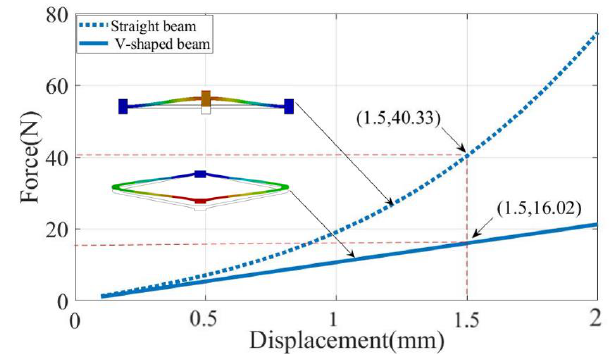
Figure 2. Comparison of the positive stiffness